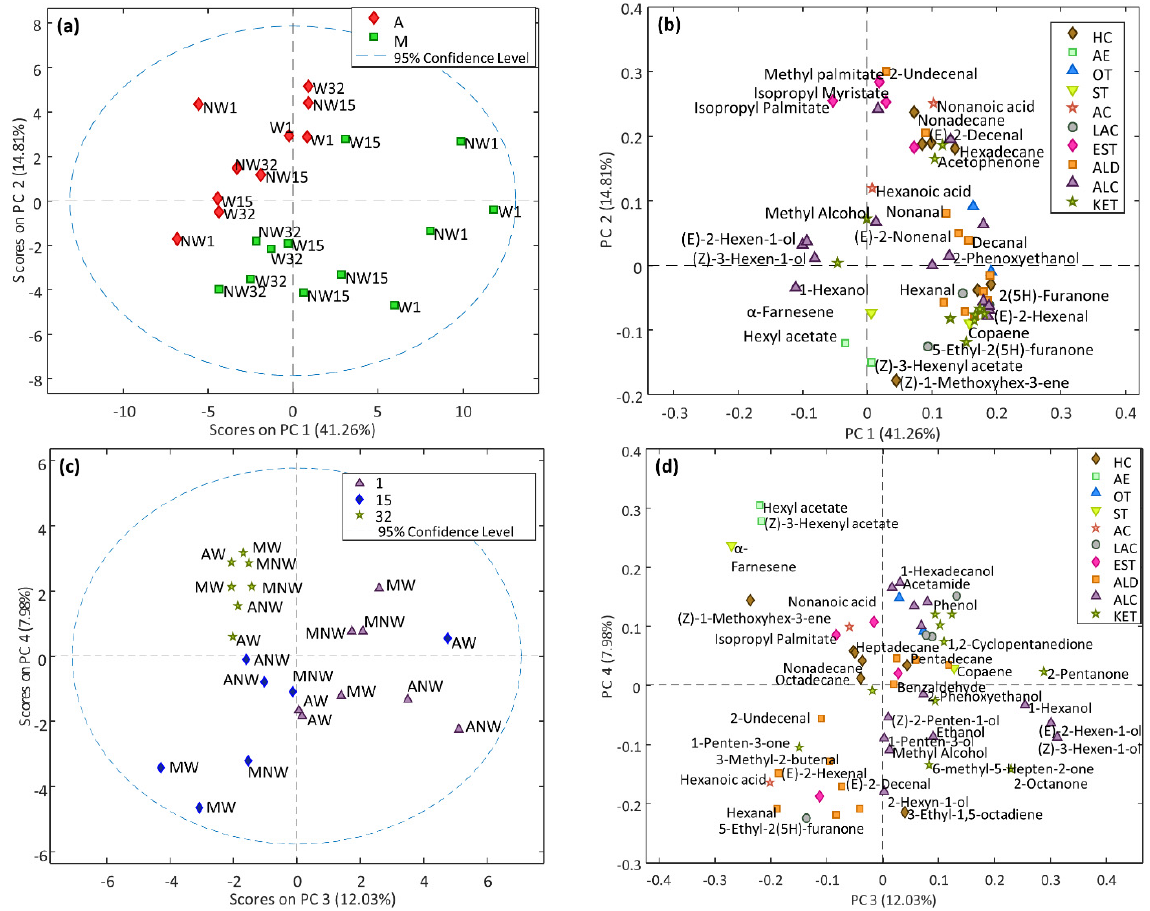
Figure 4. Scores ( a – c ) and loadings ( b – d ) plots of the PCA model of the first 4 principal components (PCs) obtained with the volatile compounds of the Organic Extra Virgin Olive Oil samples analyzed. PC1 vs. PC2 scores plot ( a ) was colored according to the time of collection, and PC3 vs. PC4 plot was colored according to the maturation stage. Notes: Morning (M) or afternoon (A), washing (W) or non-washing (NW) process; Stage I (collection day 1), stage II (collection day 15), stage III (collection day 32); HC: Hydrocarbures, AE: acetic esters, OT: other compounds, ST: (sesqui) terpenes, AC: acids, LAC: lactones, EST: esters, ALD: aldehydes, ALC: alcohols, KET: ketones.